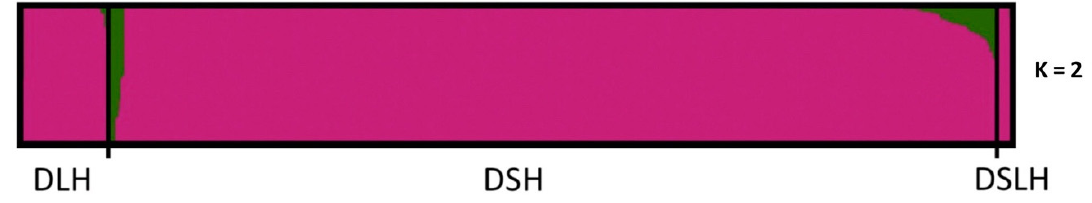
Figure 3. fastSTRUCTURE analysis of 840 DSH, DLH, and DSLH cats. At K = 2, 91% ( n = 772) random-bred cats had little evidence of admixture. Model complexity that maximized marginal likelihood was K = 2, and the model components used to explain structure in the data were K = 2.